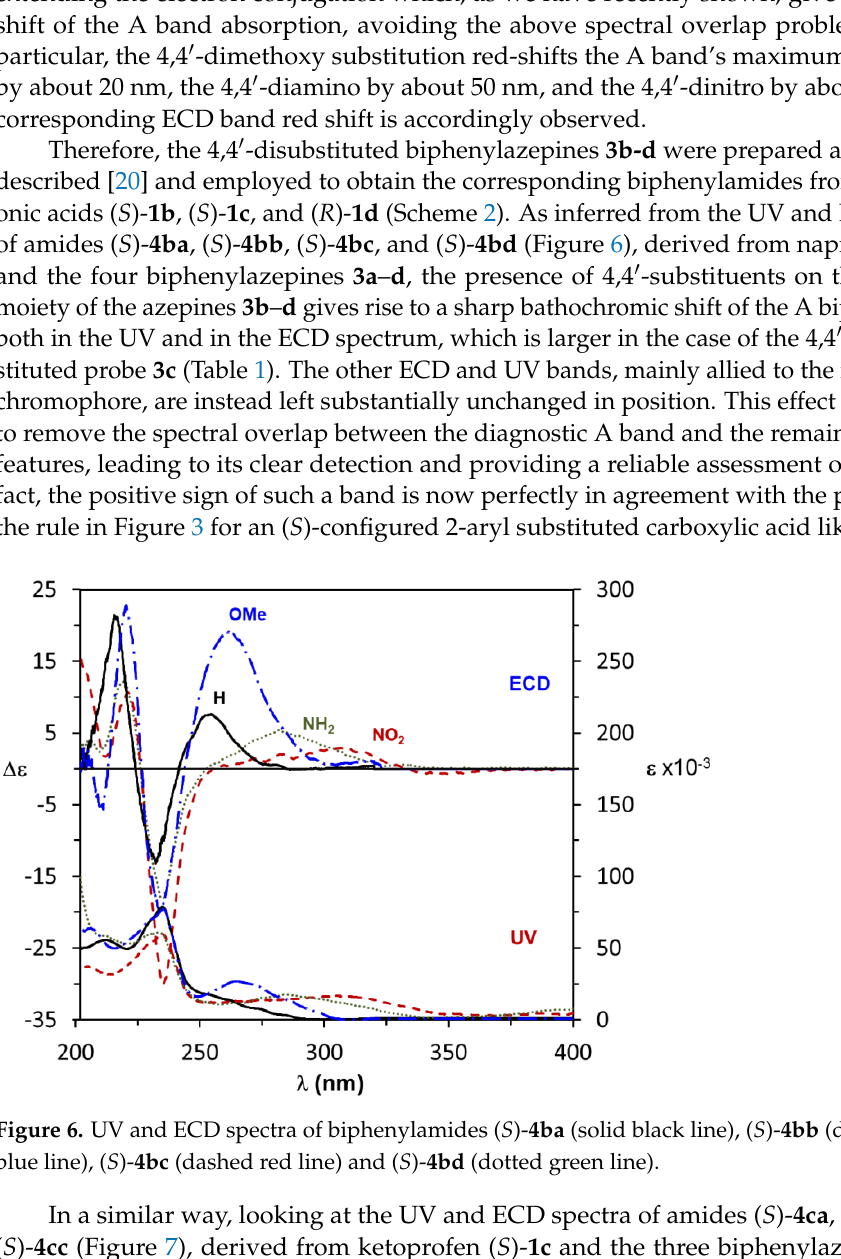
Figure 7. UV and ECD spectra of the biphenylamides ( S )- 4ca (solid black line), ( S )- 4cb (dashed dot- ted blue line) and ( S )- 4cc (dashed red line). Finally, we investigated the case of amide ( R )- 4da , ( R )- 4db, and ( R )- 4dc , derived from flurbiprofen ( R )- 1d and the three biphenylazepines 3a – c . The UV and ECD spectra of the amide ( R )- 4da-dc (Figure 8) confirm the spectral red-shift of the A band signal which, in the case of the 4,4 ′ -dinitro derivative 3d , appears at ca 310 nm and is then fully free of any other spectral overlap. This allows the clear and reliable detection of the A band sign